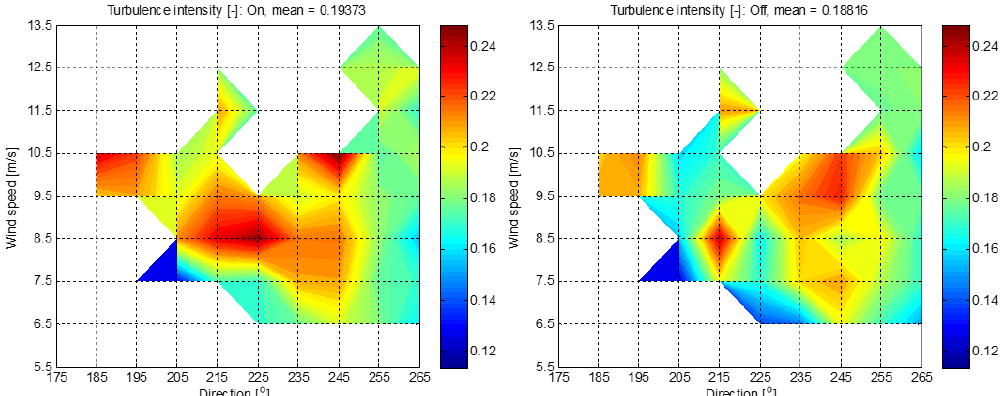
Figure 18. Mean turbulence intensities in each bin.